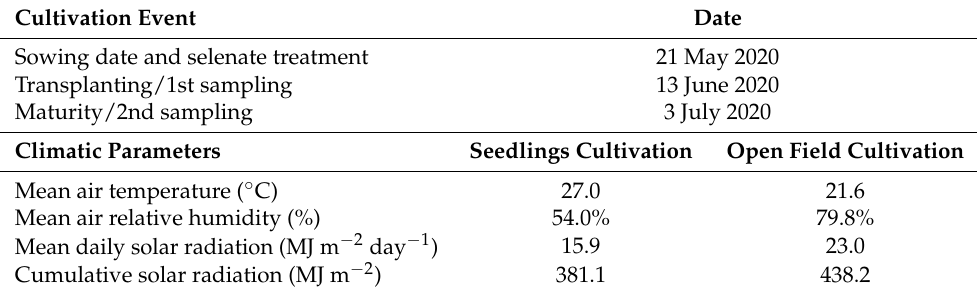
Table 1. Cultivation events and climatic parameters recorded during the